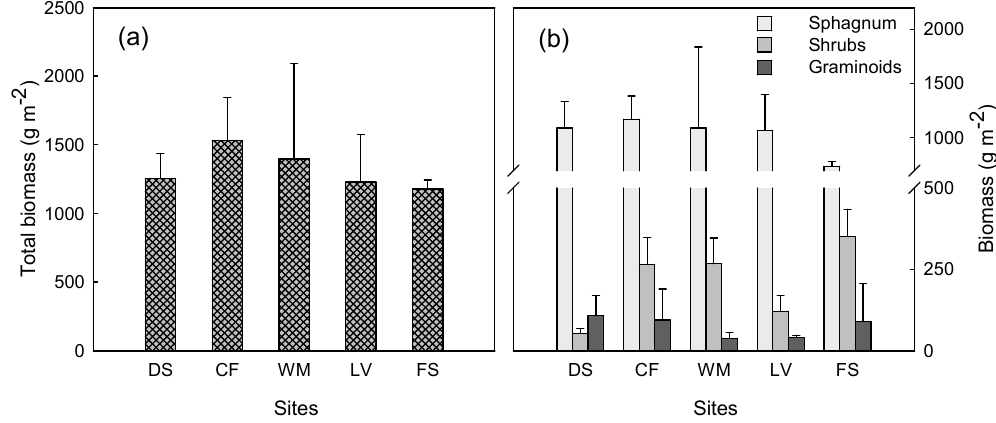
Figure 1. Total biomass (a) and the biomass of the plant functional types (b) (means ± SD). Site abbreviations: DS – Degerö Stormyr; CF – Cors Fochno; WM – Whixall Moss; LV – Lille Vildmose; FS – Frölichshaier Sattelmoor.